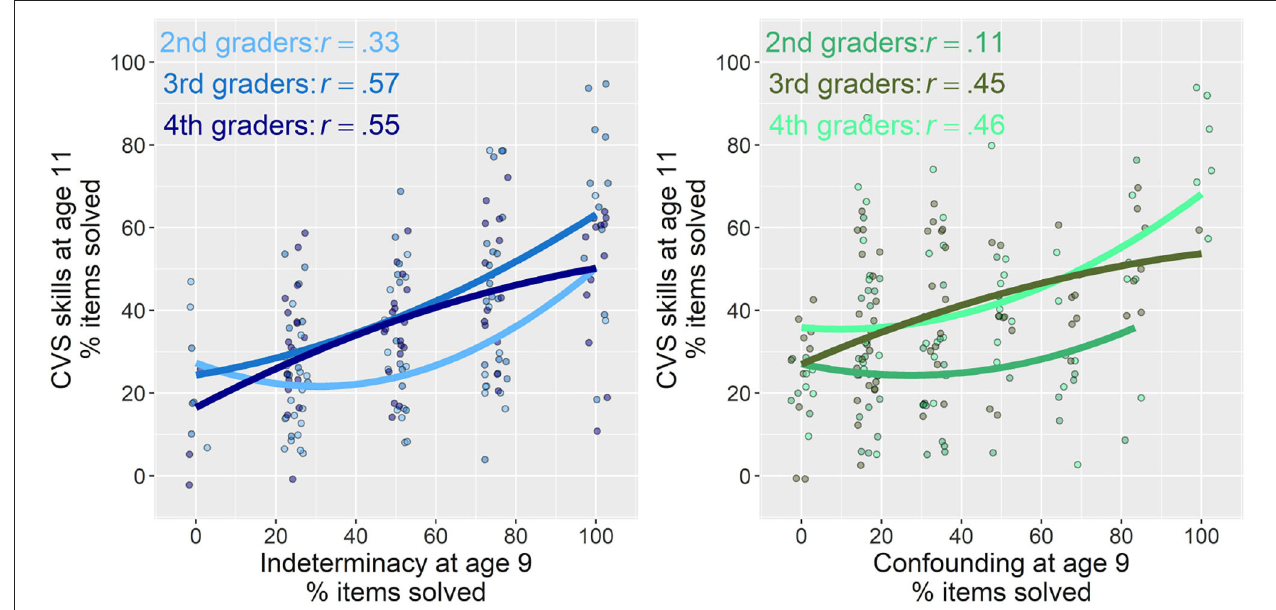
FIGURE 6 | Relations of indeterminacy (left) and confounding (right) at average age 9 with later overall CVS skill at average age 11 separate for the grades in which the first assessment took place. Pearson correlations between variables are displayed in upper left of each plot, whereas the regression lines indicate quadratic fit for a good balance of information and